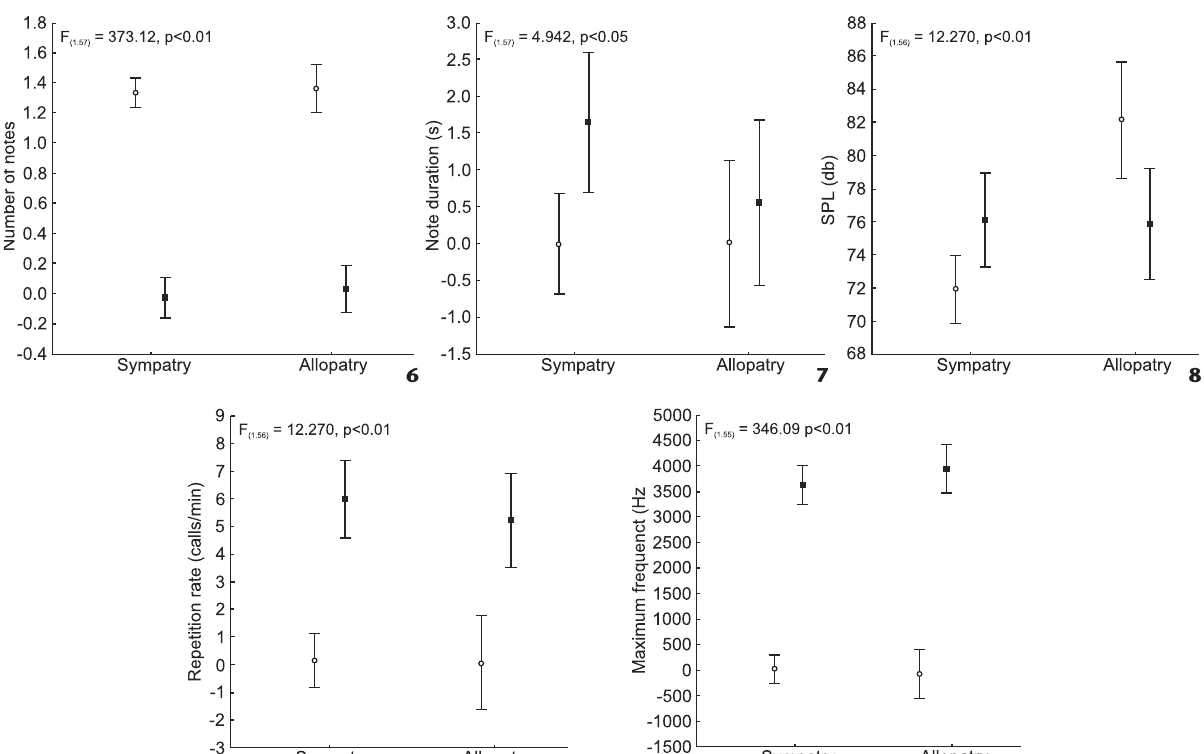
Figure 6-10. Mean and Standard Deviation of acoustic parameters of advertisement (6-8) and aggressive (9-10) calls of Hypsiboas al- bopunctatus ( ¡ ) and H. paranaiba ( n ) when in sympatry or